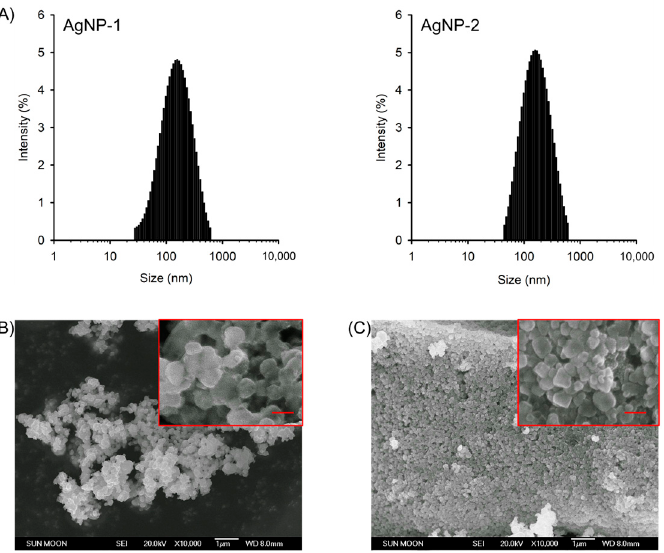
Figure 1. Physicochemical characterizations of AgNPs. Representative size distributions of ( A ) AgNP-1 and AgNP-2. Representative SEM images with a low magnification (×10,000) of ( B ) AgNP-1 and ( C ) AgNP-2 (Inset: representative SEM images with a high magnification, ×100,000. Scale bars indicate 200 nm).